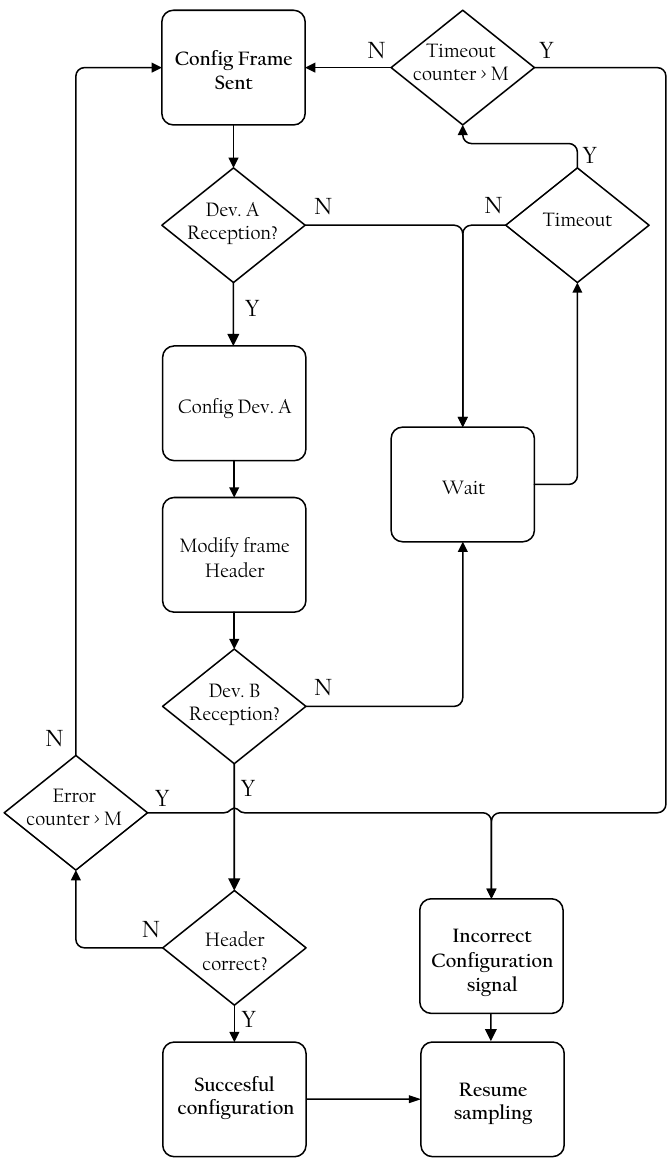
Figure 7. Flowchart of the configuration assessment protocol. Device A is the Transmitter, and Device B is the Receiver. Frame header is utilized to check if the configuration is correct. Two criteria shall be met to obtain a successful configuration: Frame received by Dev. B before a established timeout ( Dev. B Reception? ), and consistent frame header from Dev. A ( Header correct? ). If any of these conditions is not fulfilled, the process is repeated M times before considering the configuration